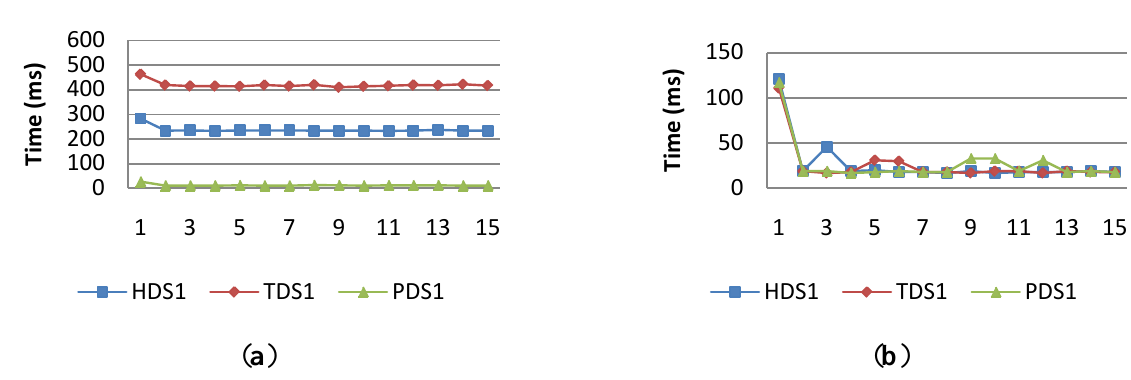
Figure 7. Execution times of device services located in R1 in ( a ) RRM mode and ( b ) VM